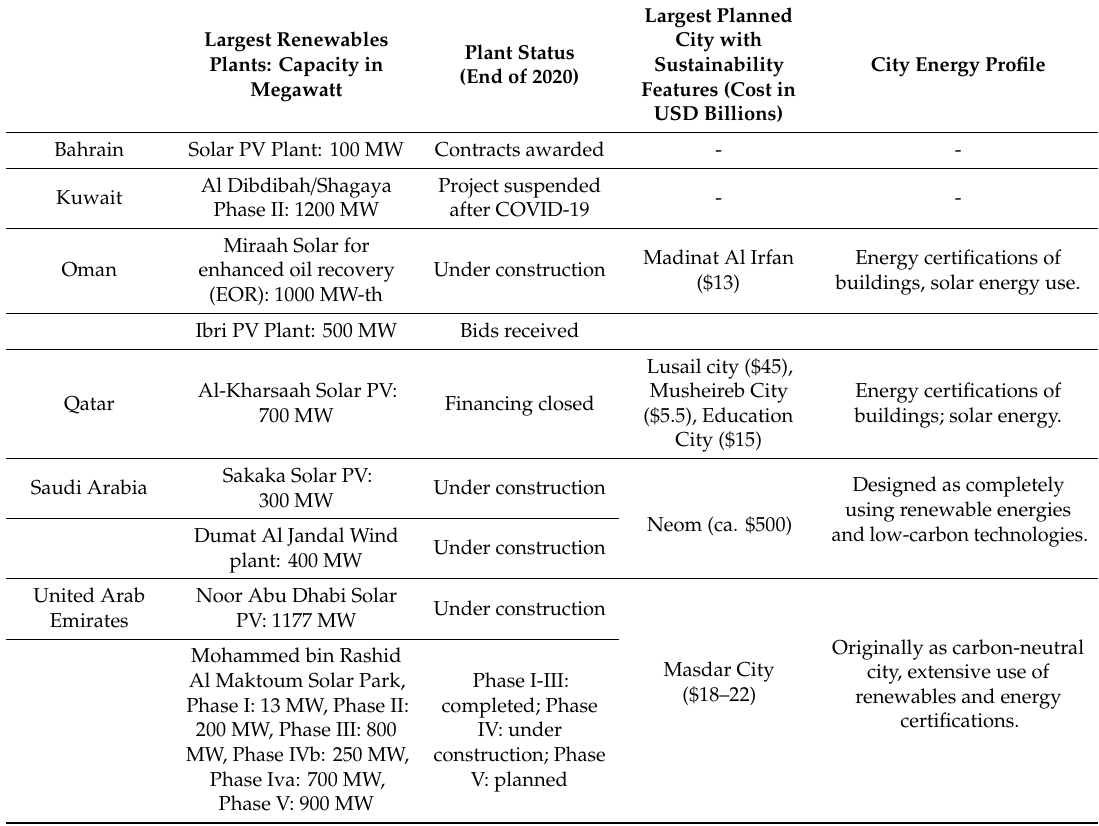
Table 3. Overview of the largest renewable plants and planned cities with sustainability